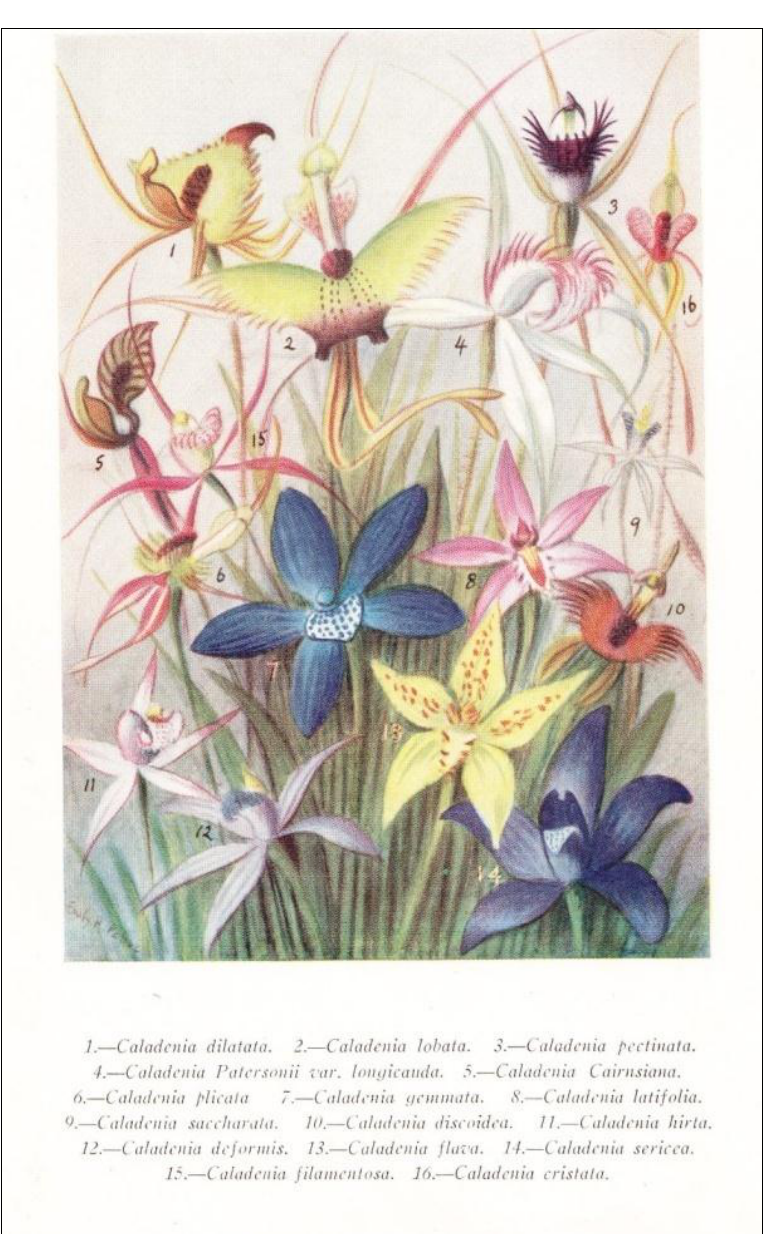
Figure 7. Color Plate I of Emily Pelloe’s West Australian Orchids featuring sixteen species of